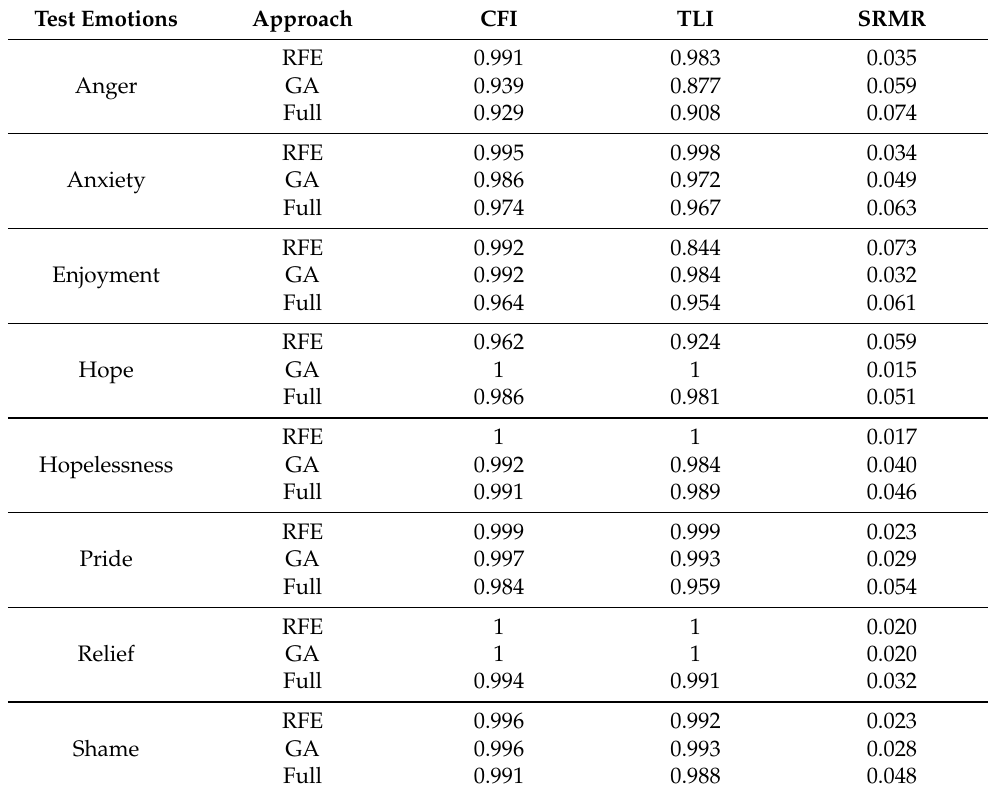
Table 2. CFA results for the full-length and abbreviated subscales of the TEQ. Test